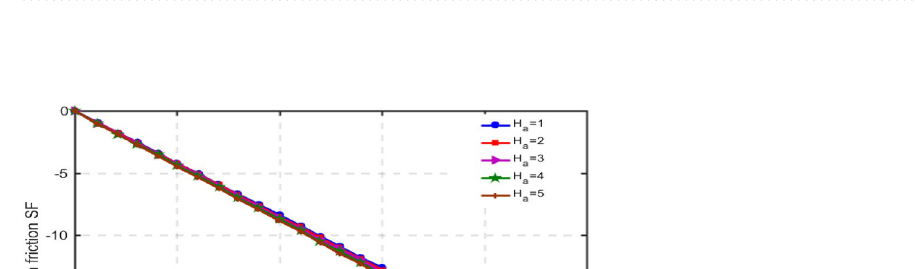
Figure 17. Variation in skin-friction for diverse values of C 6 H 9 NaO 7 parameter β .